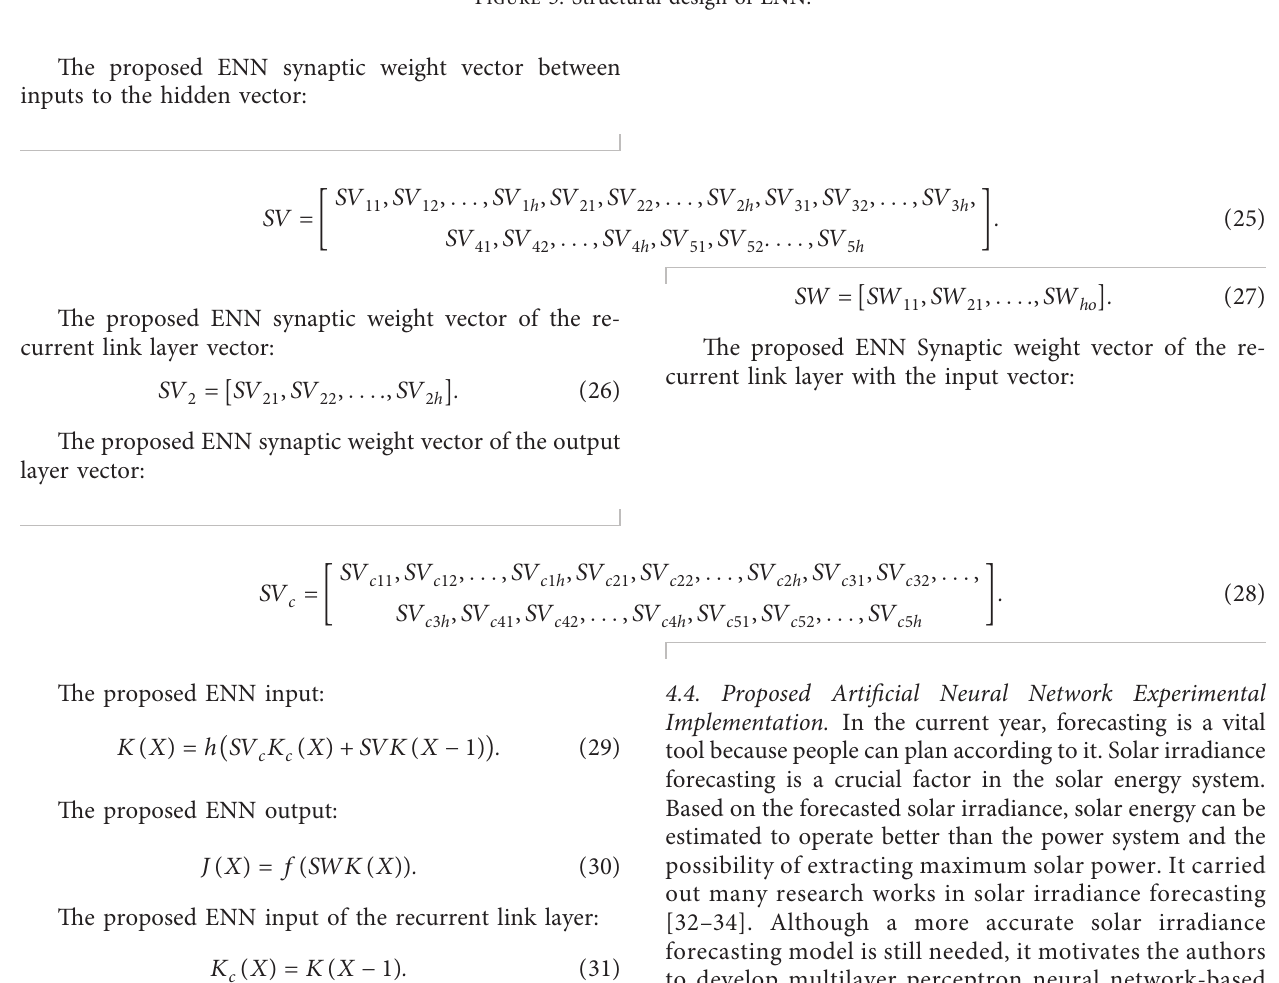
Figure 5: Structural design of